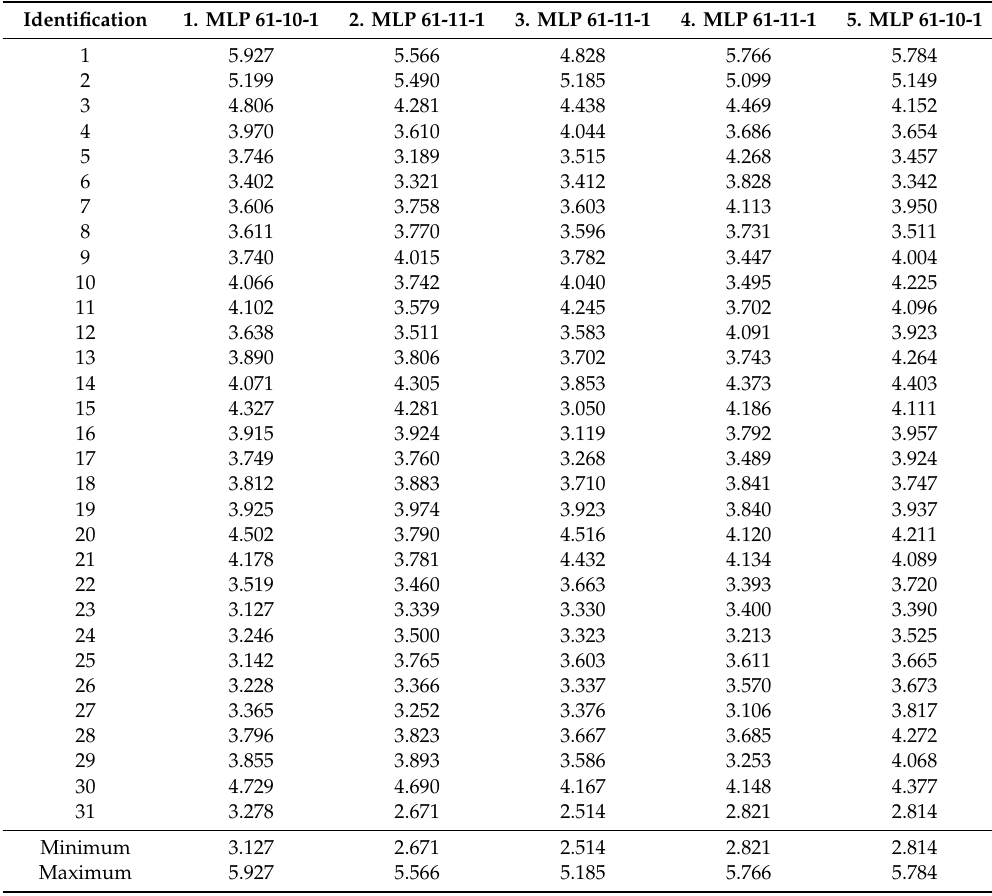
Table 11. Equalized time series absolute residuals—days of a